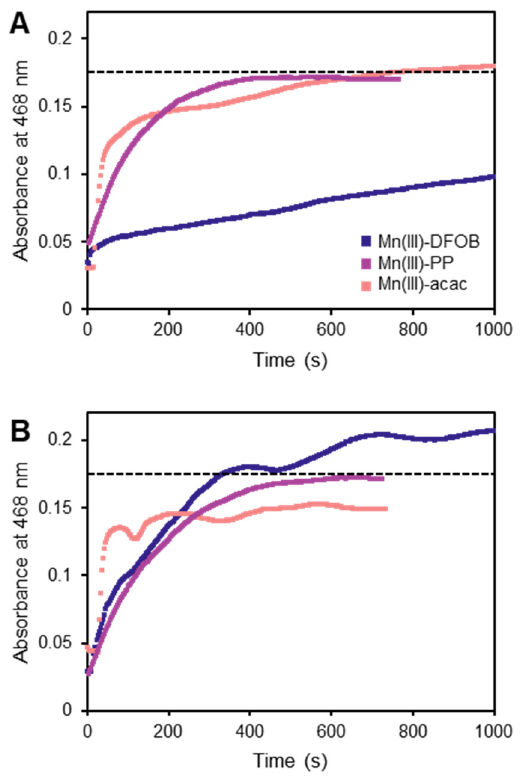
Figure 3. Reactions of Cd(II)–TCPP with Mn(III) complexes, both under air ( A ) and under argon ( B ), raise concerns about the proposed mechanism of this method. Dashed lines indicate maximum absorbance expected from 1.8 µ M Mn(III)–TCPP. ( A ) Under air, all three reactions display absorbance increasing with time monotonically. Mn(III)–DFOB reacts much more slowly than Mn(III)–PP, as previously reported. ( B ) Under argon, the Mn(III)–PP reaction behaves the same as under air. However, the Mn(III)–acac and Mn(III)–DFOB reactions display very different kinetic profiles, casting doubt on the proposed mechanism. With Mn(III)–acac, the increase in absorbance is no longer monotonic. With Mn(III)–DFOB, the reaction proceeds far more rapidly and exceeds the maximum expected absorbance.